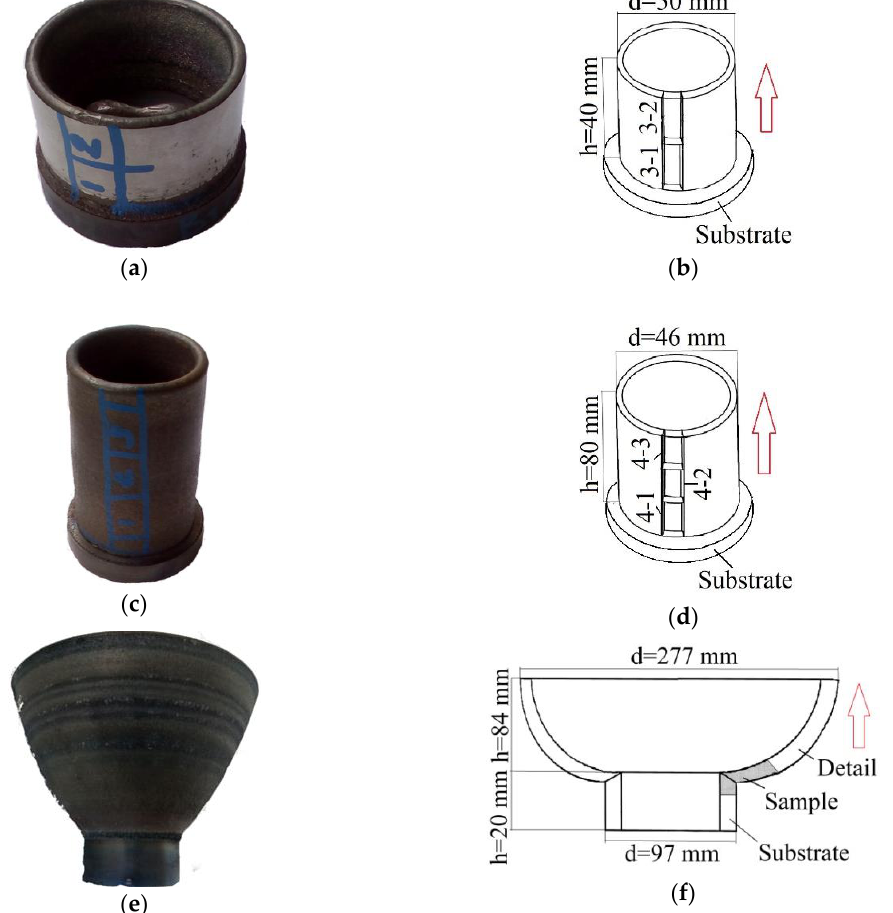
Figure 3. The appearance of the products and the cut-up sketch: (a) and (b) From detail No. 3; (c) and (d) From detail No. 4; (e) and (f) From detail No. 5. The arrows indicate the direction of application of the layers of manufactured details.